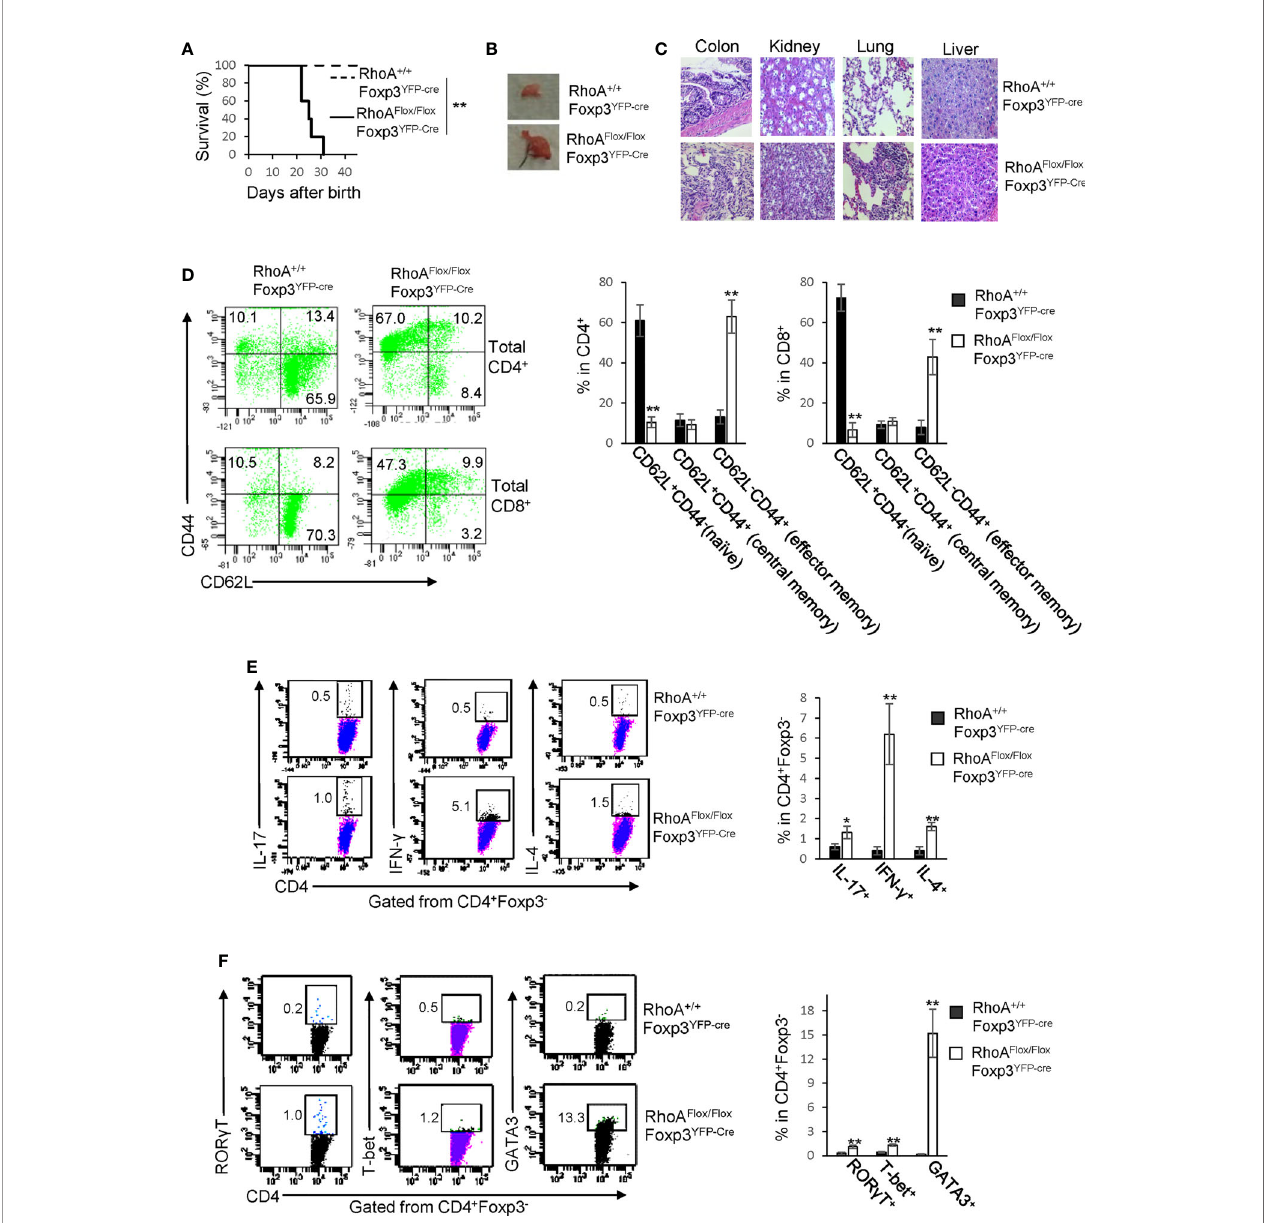
FIGURE 1 | Homozygous RhoA deletion in Treg cells leads to early, fatal spontaneous in fl ammatory disorders. (A) Survival outcome of RhoA +/+ Foxp3 YFP-Cre and RhoA Flox/Flox Foxp3 YFP-Cre mice. Results were analyzed with a log-rank (Mantel – Cox) test and expressed as Kaplan – Meier survival curves. (B) Image of lymphadenopathy in RhoA Flox/Flox Foxp3 YFP-Cre mice. Inguinal lymph nodes are shown. (C) Images of H&E staining of the indicated organs from RhoA +/+ Foxp3 YFP-Cre and RhoA Flox/Flox Foxp3 YFP-Cre mice (original magni fi cation X 400). (D) Left, representative fl ow cytogram of CD44 and CD62L staining in CD4 + and CD8 + cells from the spleen of RhoA +/+ Foxp3 YFP-Cre and RhoA Flox/Flox Foxp3 YFP-Cre mice. The numbers indicate percentages of CD44 + , CD44 + CD62L + , and CD62L + cells. Right, average percentages of CD44 + , CD44 + CD62L + , and CD62L + cells. (E) Left, representative fl ow cytogram of IL-17, IFN- g , and IL-4 staining in CD4 + Foxp3 - cells from the spleen of RhoA +/+ Foxp3 YFP-Cre and RhoA Flox/Flox Foxp3 YFP-Cre mice. The numbers indicate percentages of IL-17 + , IFN- g + , and IL-4 + cells. Right, average percentages of IL-17 + , IFN- g + , and IL-4 + cells. (F) Left, representative fl ow cytogram of ROR g T, T-bet and GATA3 staining in CD4 + Foxp3 - cells from the spleen of RhoA +/+ Foxp3 YFP-Cre and RhoA Flox/Flox Foxp3 YFP-Cre mice. The numbers indicate percentages of ROR g T + , T-bet + , and GATA3 + cells. Right, average percentages of ROR g T + , T-bet + , and GATA3 + cells. (A, D – F) n = 3-5 mice. Data are representative of two independent experiments. Error bars indicate SD. *p < 0.05, **p < 0.01. (B, C) Data are representative of 3